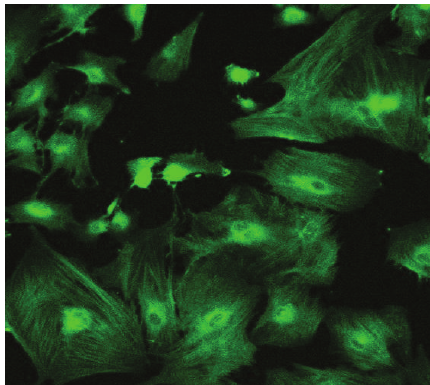
Figure 3: Immunofluorescence image of ERM cells using an antibody to cytokeratin 19 (CK 19). ERM cells were positive for CK